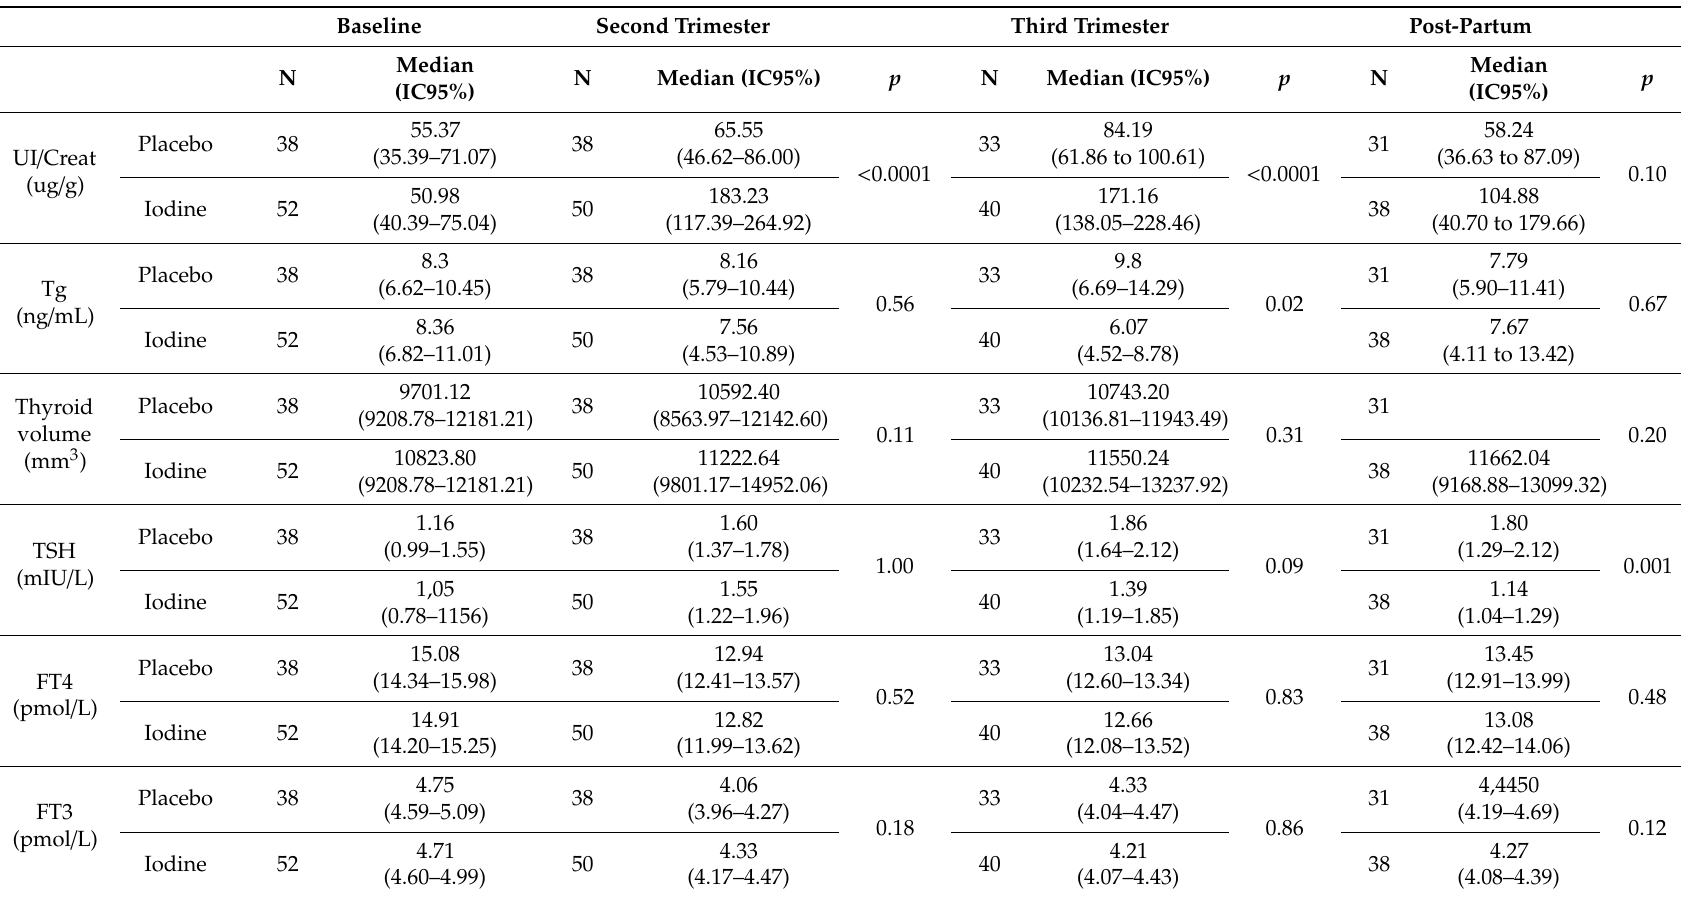
Table 2. Maternal laboratory test findings during pregnancy, at the baseline, in the second and third trimesters, and